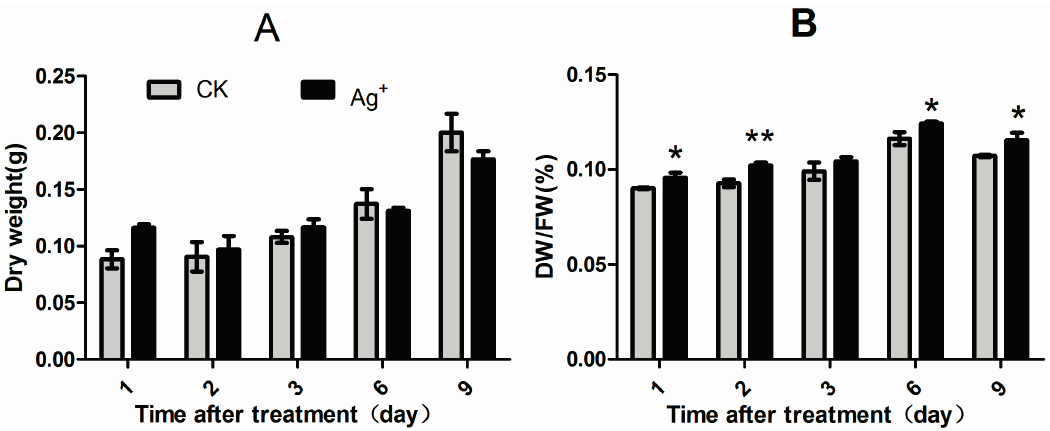
Figure 3. Effects of Ag + elicitor on cell growth of S. miltiorrhiza hairy roots. ( A ) Dry weight (DW) of the S. miltiorrhiza hairy roots after Ag + treatment; ( B ) Dry weight/Fresh weight (FW) ratio of the S. miltiorrhiza hairy roots after Ag + treatment. The vertical bars show the SD values ( n = 3). The asterisks indicate statistically significant differences at p < 0.05 ( * , 0.01 < p < 0.05; ** , 0.001 < p < 0.01.) between the content in the elicitor treated cultures and that in the corresponding controls.